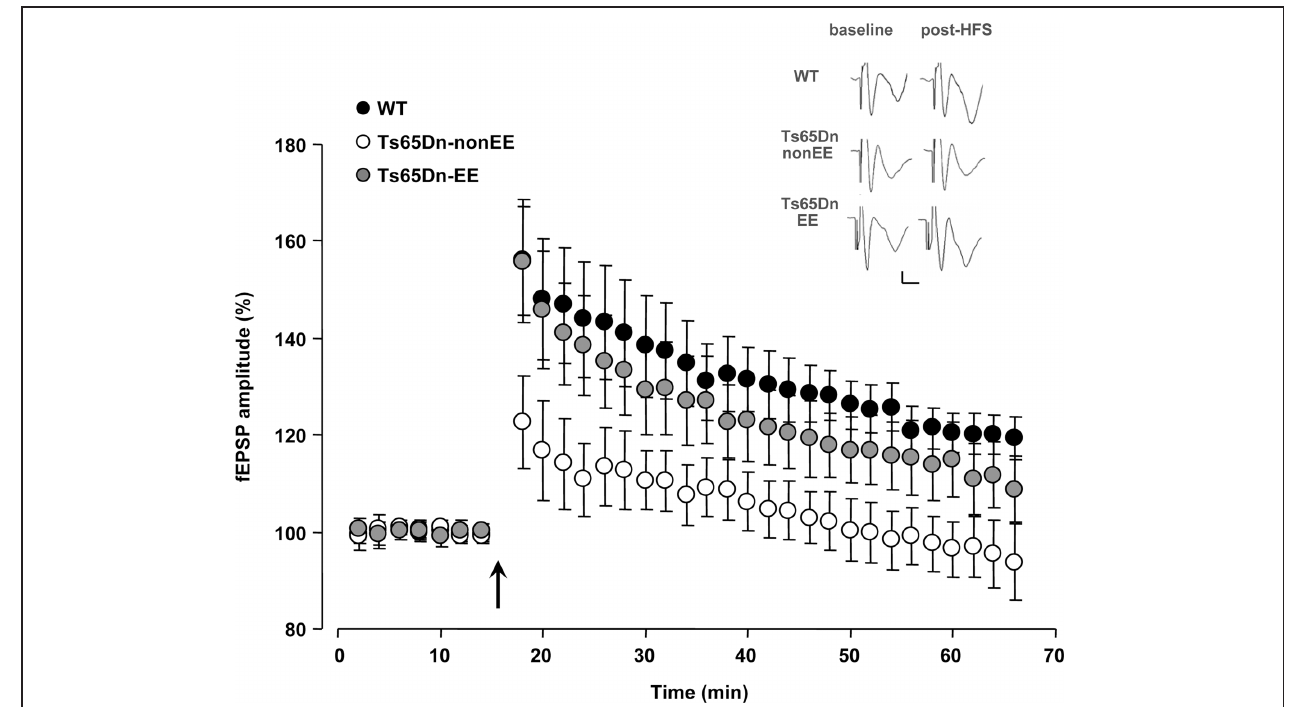
p = 1). A multiple comparison procedure (Holm–Sidak method) showed a statistical difference in LTP levels between WT and Ts65Dn-non-EE mice, between Ts65Dn-non-EE mice and Ts65Dn-EE mice and between WT and Ts65Dn-EE mice ( p < 0 . 001). Sample traces (vertical scale bar: 200 µ V ; horizontal scale bar: 2ms) from the three experimental groups before (baseline) and after HFS (post-HFS) are also reported. The arrow indicates HFS. *Statistical significance; error bars,